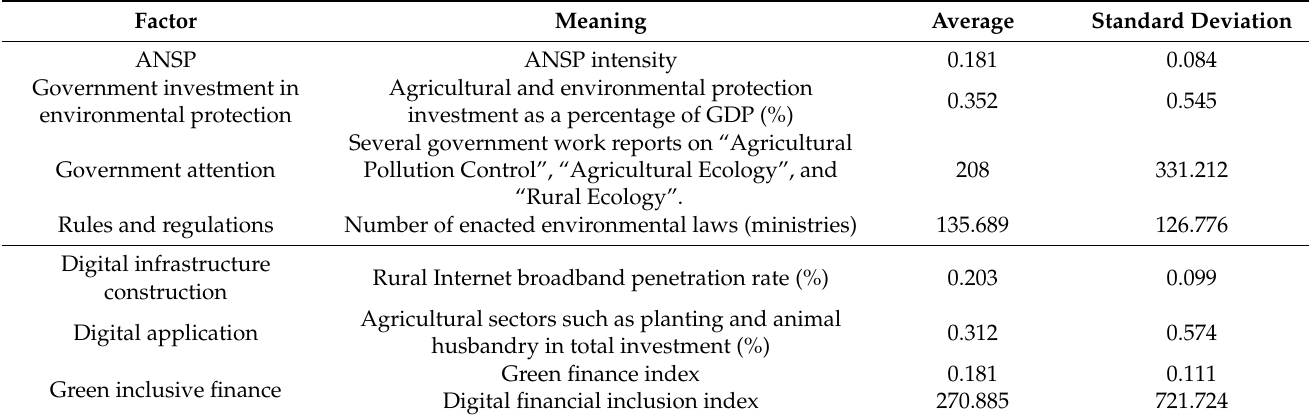
Table 1. Variable description and descriptive